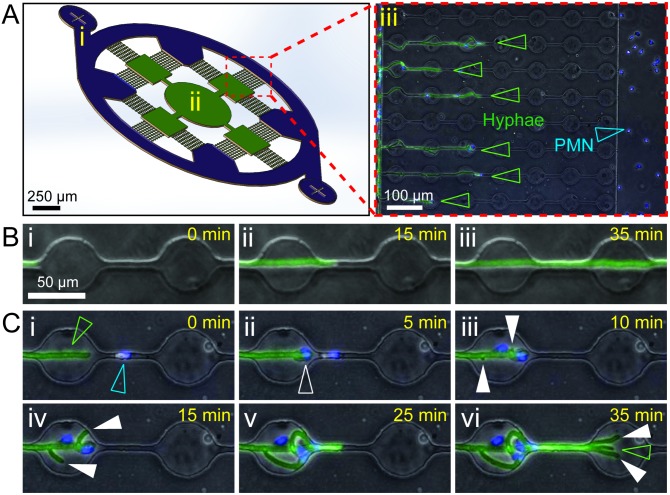
Neutrophil interactions induce hyphal branching.(A) Schematic of microfluidic device used in the study. The device consists of a circular outer channel and neutrophil loading ports (i, purple), inner conidia loading port (ii) and hyphal growth chambers (green), and 12 viewing fields consisting of 9 conidia-hypha interaction channels per field (magnified in iii). (iii) The interaction channels guide parallel growth of individual hypha (EGFP, open green arrowheads) from the hyphal growth chambers and enables observation of interactions with neutrophils/polymorphonuclear (PMN) leukocytes (Hoechst, open blue arrowheads) loaded into the circular outer channel (S1 Movie). (B) Hyphal growth through the interaction channels in the absence of neutrophils is linear and rarely involves spontaneous branching (<5%). (C) Rapid induction of hypha branching upon interaction with neutrophils (S2 Movie). (i) Neutrophils (Hoechst, open blue arrowhead) are recruited to the hyphal tip (EGFP, open green arrowhead) and make contact with the hypha (ii, open white arrowhead). This rapidly induces formation of new hyphal tips (iii-iv, full white arrowheads) proximal to the interaction. (vi) This may result in amplification of hypha number, with new hypha (full white arrowheads) adding to existing hypha tips (open green arrowhead).